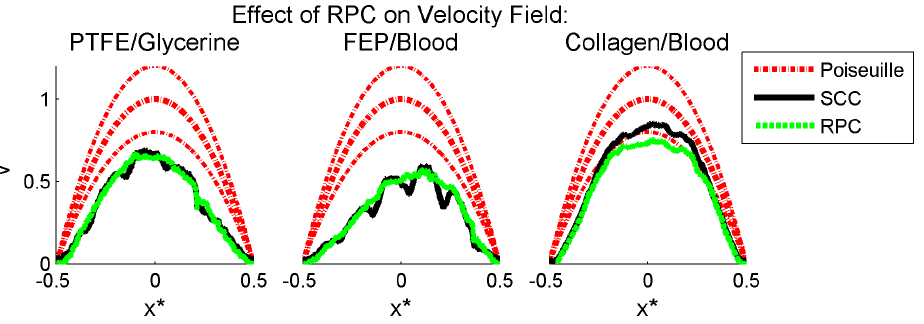
Figure 6. Effect of PIV correlation method on PIV accuracy. Mean velocity profiles obtained using standard cross-correlation (solid black lines) and robust phase correlation with 2.8 pixel diameter (dashed green lines) applied to processed images are plotted with the volume-adjusted Poiseuille solution (dashed red lines) for each experimental case. The uncertainty based on measured flow rate and vessel diameter is plotted for the theoretical solution (upper and lower dashed red lines). The 95% confidence interval on the mean for the experimental data is not distinguishable from the mean. Left to right: glycerine-perfused PTFE, blood-perfused FEP, and blood-perfused collagen. Data shown is averaged in time and along the length of the vessel and is normalized for each experimental case by the vessel diameter and theoretical maximum